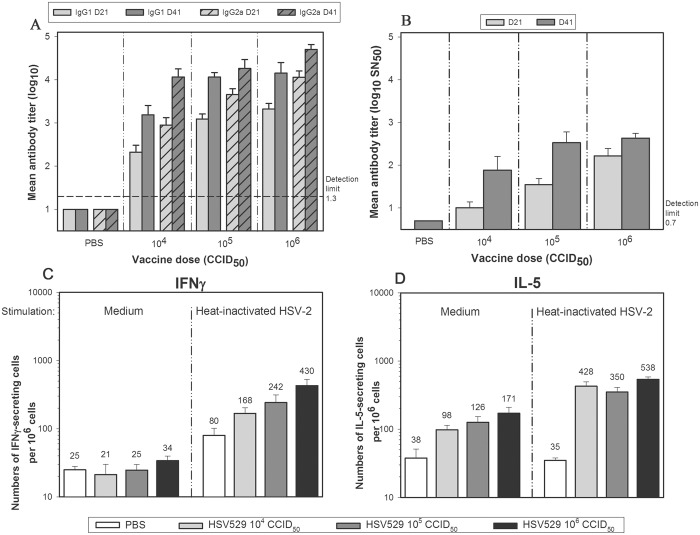
Mice immunized with HSV529 produce HSV-2-specific IgG1 and IgG2a antibodies, neutralizing antibodies, and HSV-2-specific splenic lymphocytes secreting IFNγ and IL-5.BALB/c mice (n = 10/group) were immunized with HSV529 (104 CCID50, 105 CCID50, or 106 CCID50) or PBS by the i.m. route on days 0 and 21. Sera were collected on days 21 (D21; n = 10) and 41 (D41; n = 5). (A) HSV-2-specific IgG1 and IgG2a antibody titers in the sera were determined by ELISA using a lysate prepared from HSV-2-infected Vero cells and secondary antibodies specific for mouse IgG1 and IgG2a. (B) HSV-2 neutralizing antibodies in the sera were measured by preincubating dilutions of heat-inactivated sera with 100 CCID50 of live HSV-2 (strain G) virus for 1 hour prior to infection of Vero cell cultures. Infected cells were detected with anti-HSV glycoprotein D antibodies. The serum dilution that neutralized 50% of the virus (SN50) was determined by plotting the neutralization activity versus the serum dilutions. Splenic lymphocytes secreting IFNγ (C) or IL-5 (D) in response to ex vivo stimulation with heat-inactivated HSV-2 (strain G) were counted using an ELISPOT assay. Error bars represent standard error of the mean.